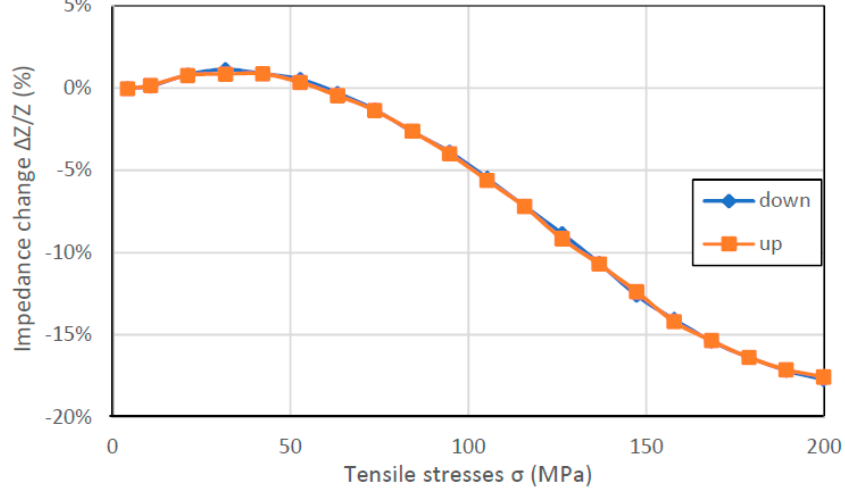
Figure 8. Hysteresis SI measurements of Co 70 Fe 5 Ni 2 Mo 5 B 3 Si 15 sample (for 1 MHz driving signal).